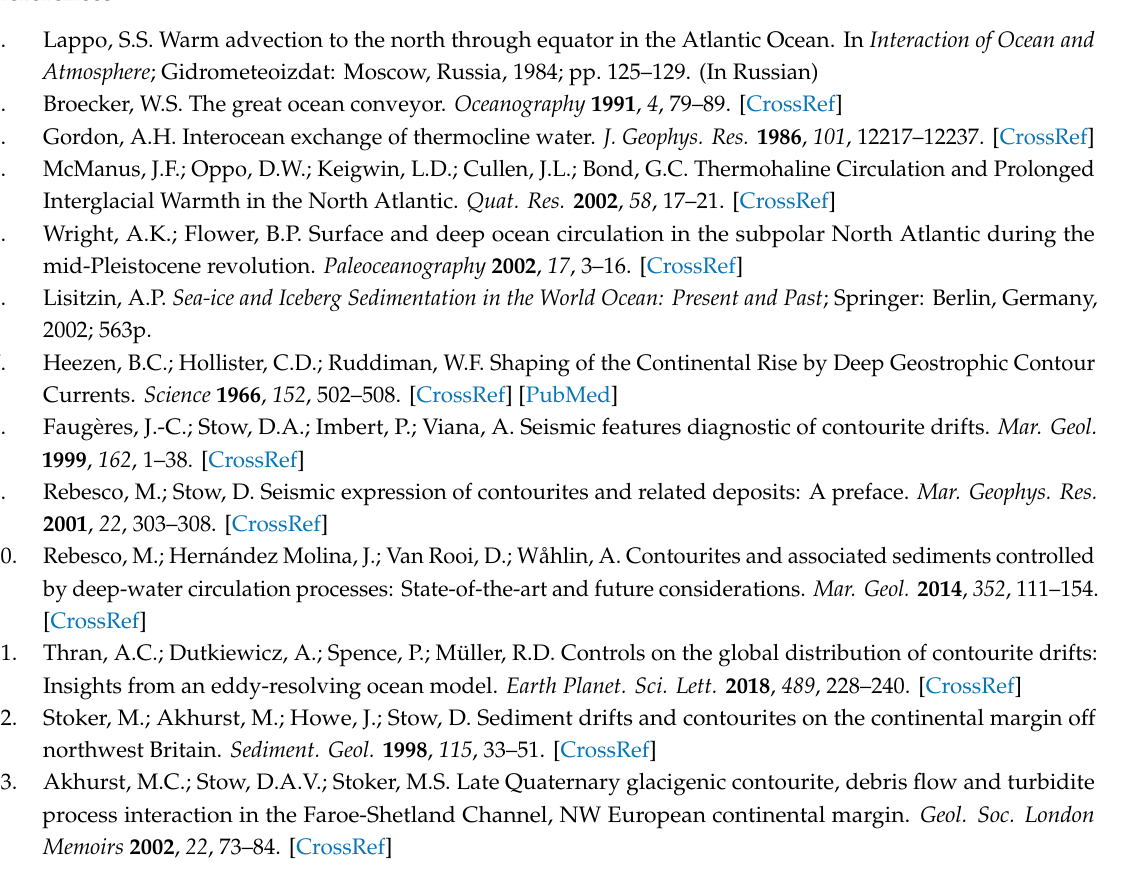
Table S1: The IRD counts, ∂ 18 O, ∂ 13 C, contents (wt.%) of CaCO 3 and TOC in sediment cores of the Snorri and Gloria